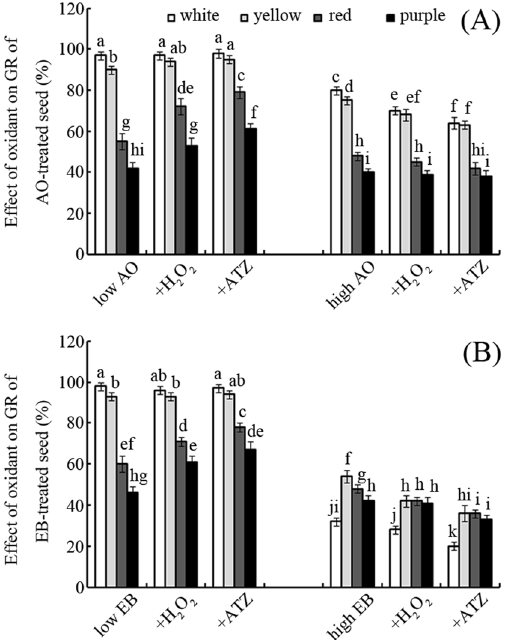
Figure 6. Effects of oxidants on GR Effects of oxidants (H 2 O 2 and ATZ, 10 mM) on the GRs of maize seeds treated with low (left) or high (right) concentrations of AO ( A ) and EB ( B ). Bars represent standard deviations of means ( n = 5); means followed by the same letter are not significantly different ( p < 0.05) among treatments. Low (0.5 mg ml − 1 for AO, 50 μ g ml − 1 for EB) or high (5 mg ml − 1 for AO, 500 μ g ml − 1 for EB) concentrations of AO/EB represent controls. H 2 O 2 , hydrogen peroxide; ATZ, aminotriazole; AO, acridine orange; EB, ethidium bromide; GR, germination